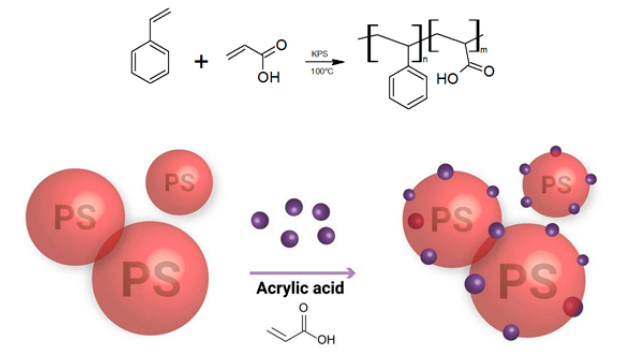
Figure 1. Schematic illustration of the synthesis process for the preparation of a polystyrene (PS)– acrylic acid (AA) copolymer.